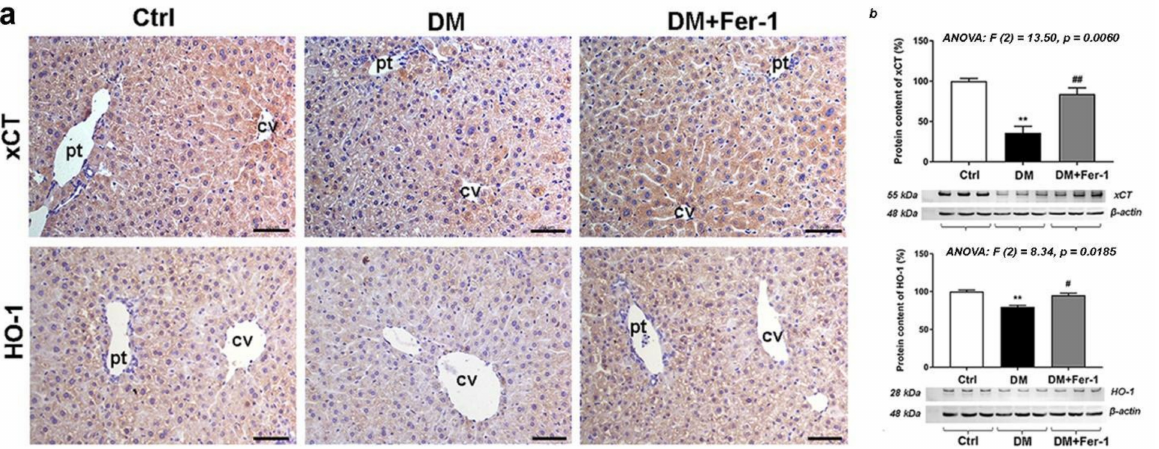
Figure 5. Detection of xCT and HO-1 ( a ) immunohistochemical localization and ( b ) protein expression in the liver tissue of control (Ctrl), diabetic (DM), and diabetic Fer-1-treated (DM + Fer-1) animals. Scale bars: 50 µ m; cv—centrilobular vein, pv—portal vein. Values presented as means ± SEM. Statistical significance: compared with the Ctrl group (*), ** p < 0.01. DM vs. DM + Fer-1 comparison (#), # p < 0.05, ## p <